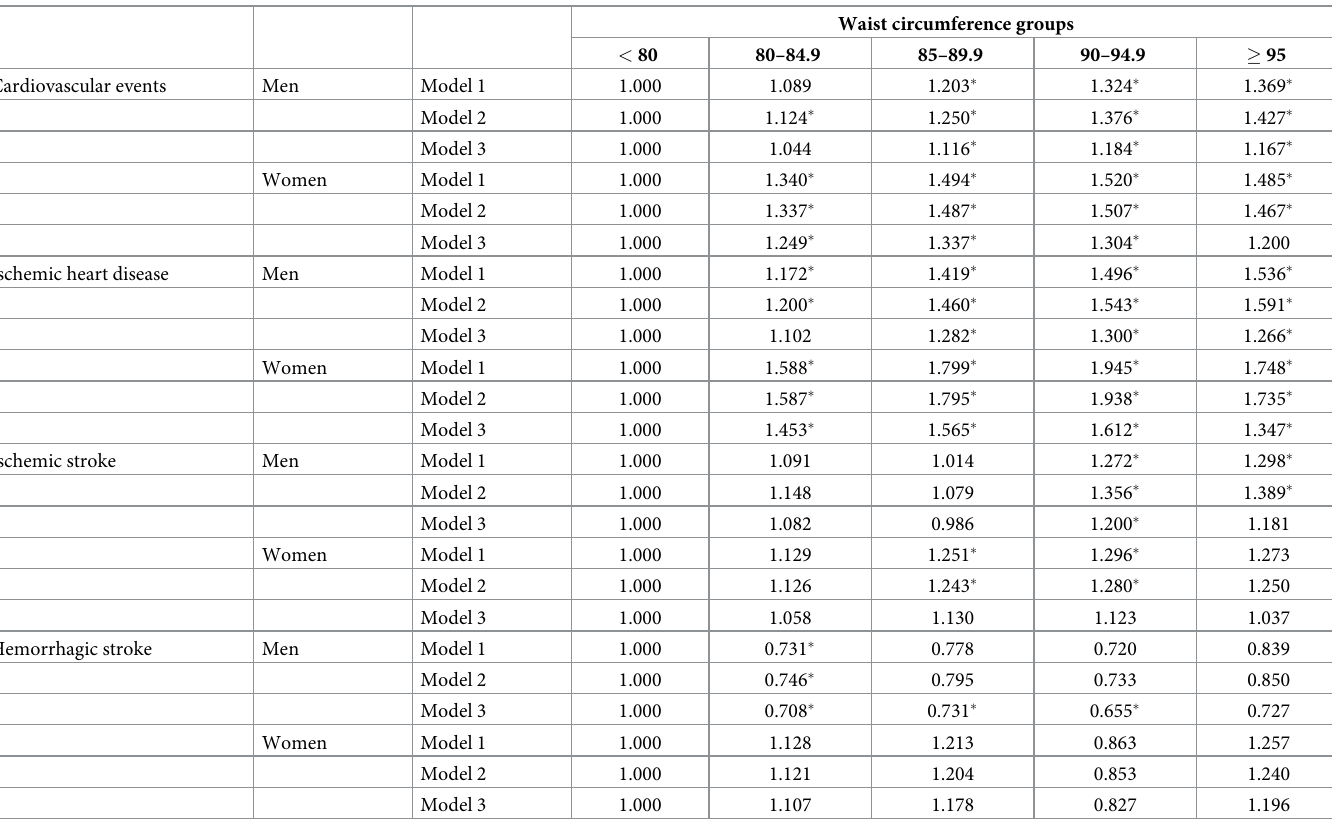
Table 4. Hazard ratio for cardiovascular events according to waist circumference